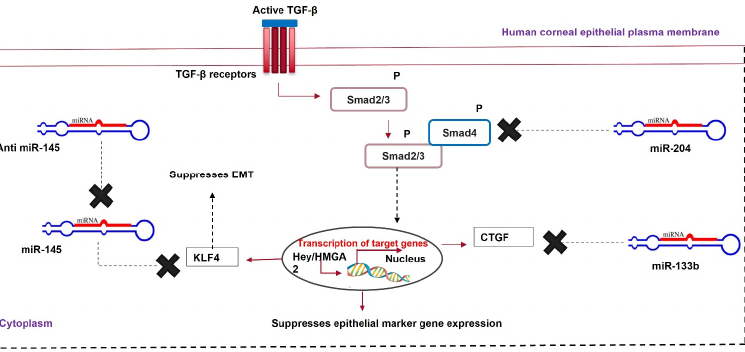
Figure 4. MicroRNA therapy for corneal scarring. Upregulation of miR-204 and miR-133b and downregulation of miR-145 help in healing a scarred cornea via modulating Krüppel-like factor 4 (KLF4), Smad2/3, and CTGF.